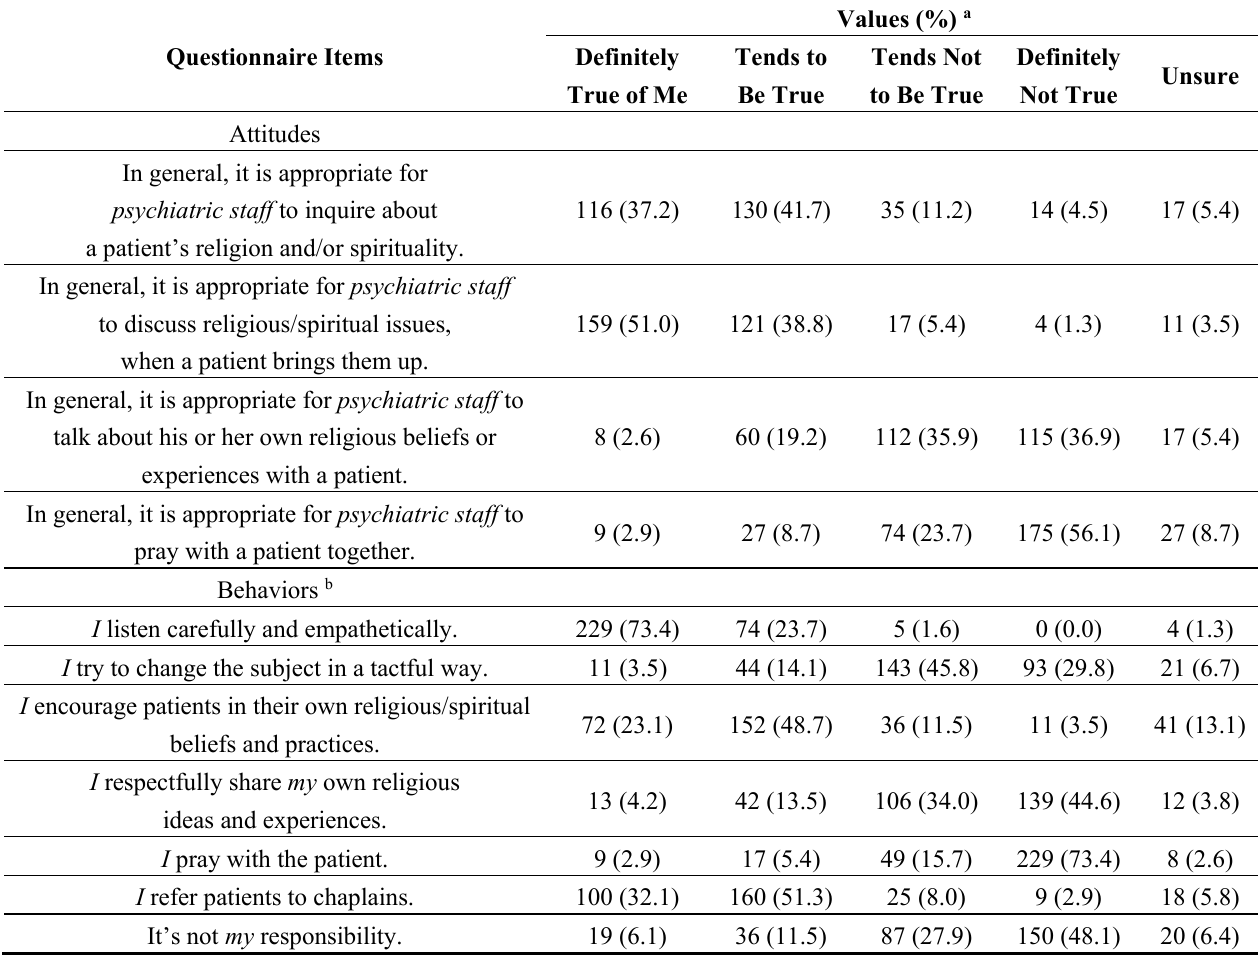
Table 3. Psychiatric staff’s attitudes and self-rated behaviors regarding